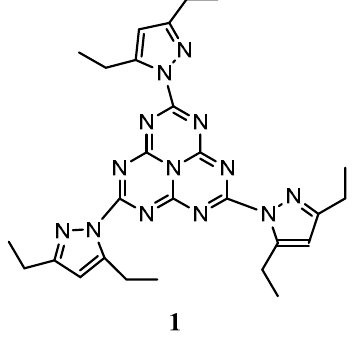
Figure 1. Formula of heptazine 1 used in this work.